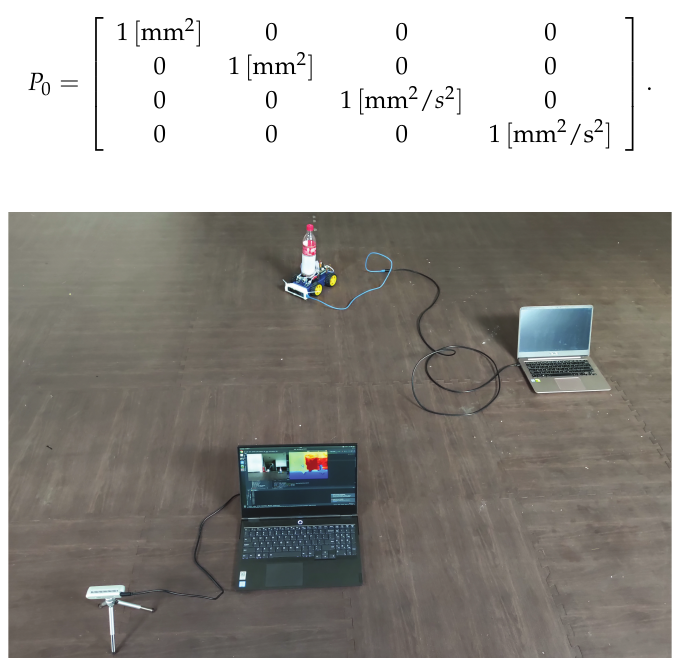
Figure 11. Experimental